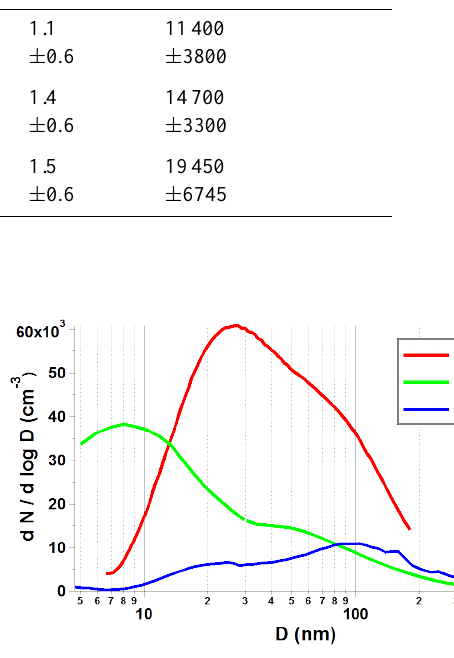
Fig. 2. Average particle number concentrations (cm − 3 ) as a func- tion of time of day for M. Road, R. Park, North Kensington and BT Tower . All measurements were taken with the same instruments (CPC TSI 3022A) apart from R. Park (TSI 3776). All the data are from the REPARTEE I field study.